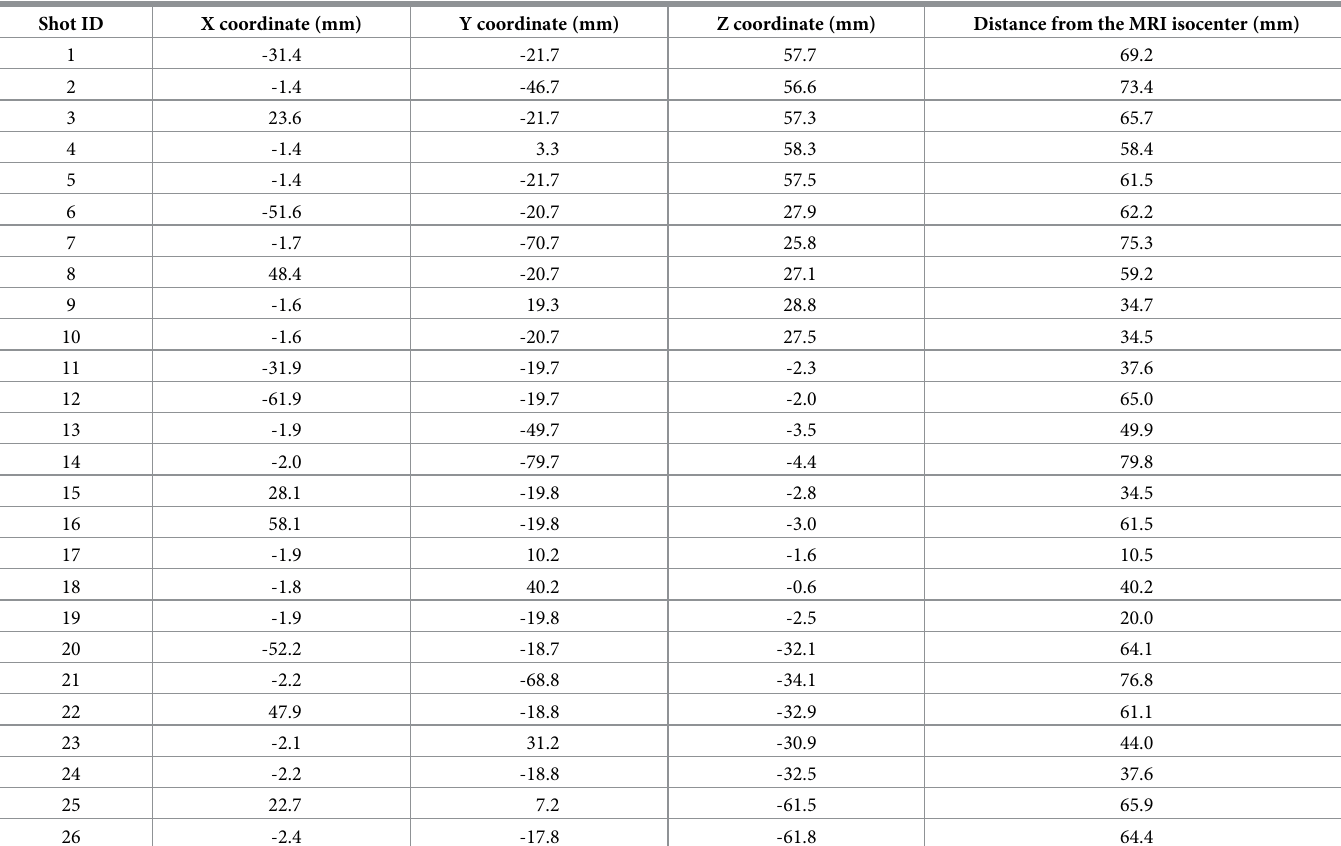
Table 2. Reference control point locations (i.e., centers of the GK shots) in the MRI DICOM coordinate system. Shot ID X coordinate